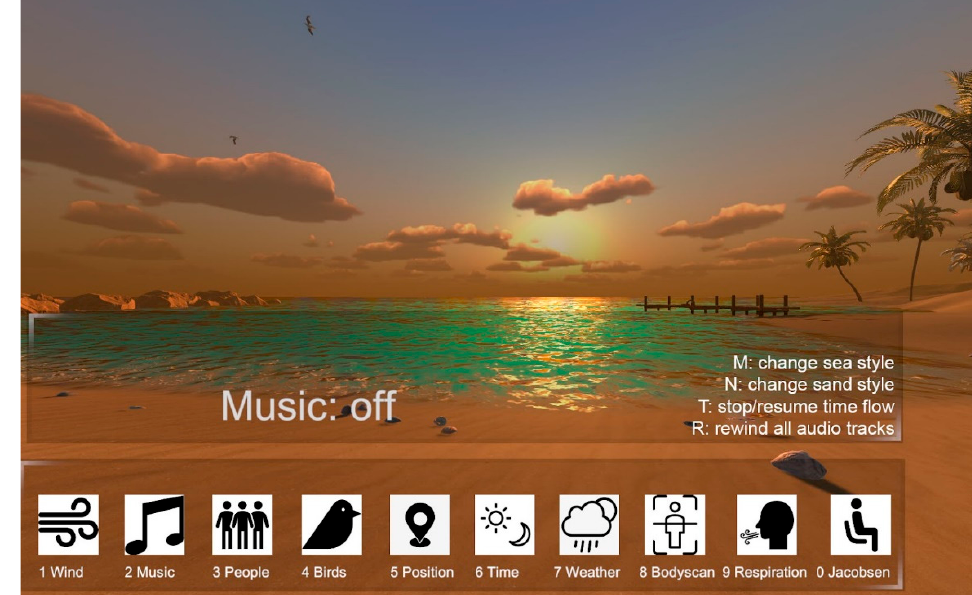
Figure 1. Screenshot of the interface.